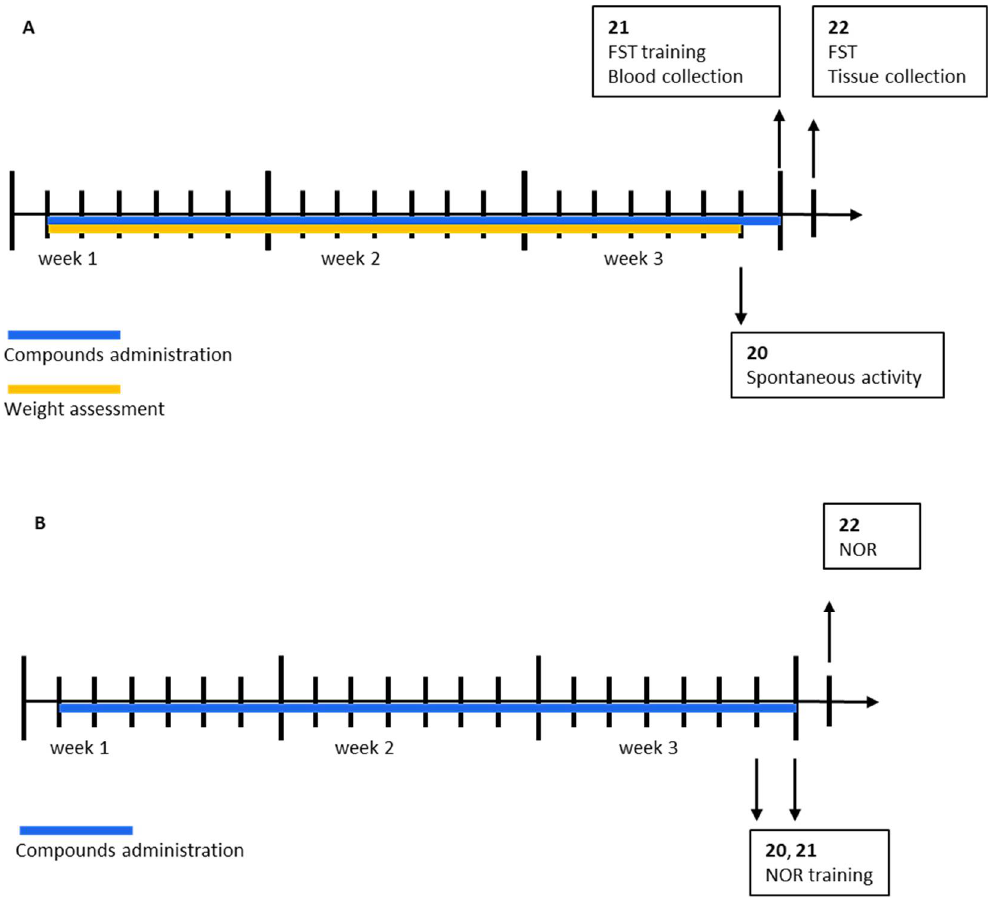
Scheme 1. Schematic diagrams of experimental procedures. ( A ) Chronic treatment for FST and